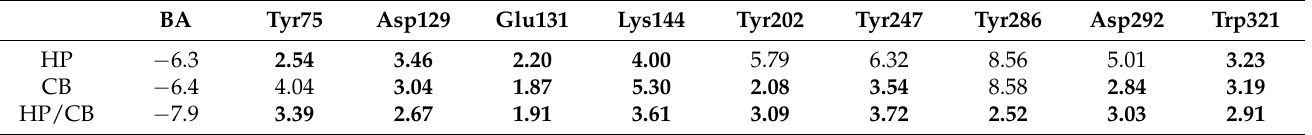
Table 6. Binding affinity (BA) in kcal · mol − 1 computed for HP-CB, HP, and CB bound to hHyal-1 and key distances in Å between Hyal-1 amino acids and ligands. Hydrogen bonds are marked in